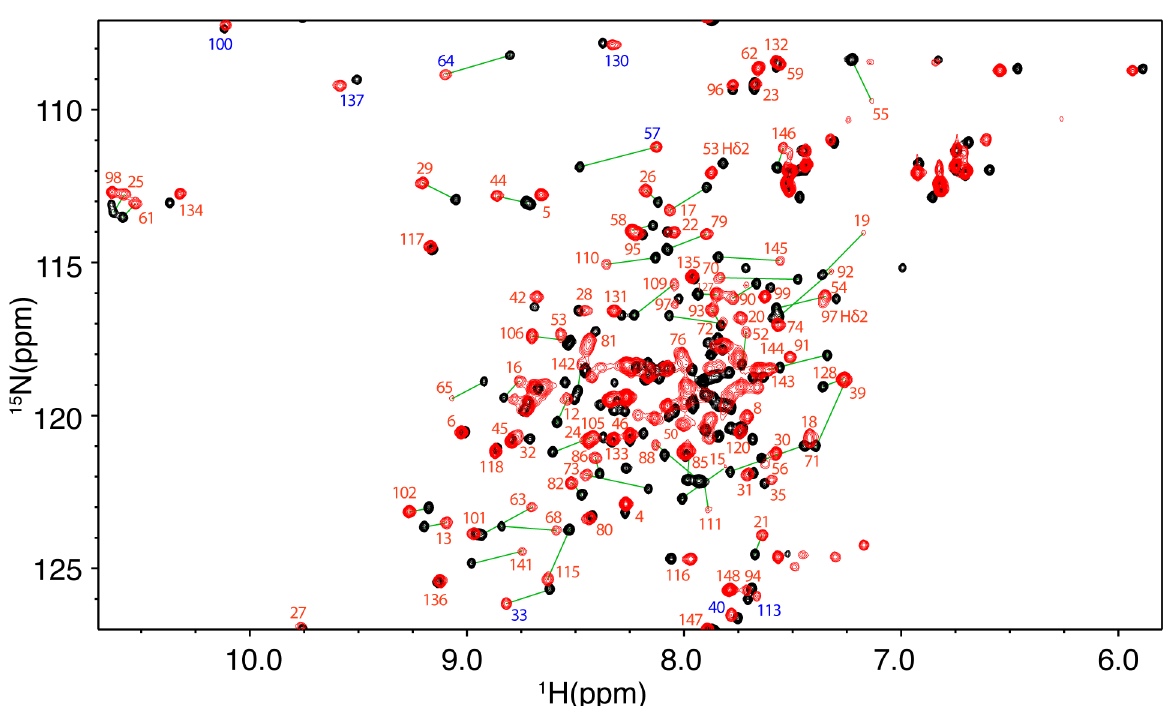
Fig 5. 2D HSQC NMR data of Ca 2+ /CaM:Fas-Pep1 complex. Overlay of 2D 1 H- 15 N HSQC spectra obtained for 15 N-labeled Ca 2+ /CaM in the free state (black) and in complex with Fas-Pep1 (red) at 1.5:1 peptide: Ca 2+ /CaM. No chemical shift changes were observed in the HSQC spectra with further addition of Fas-Pep1, indicating saturation at this ratio. Signal labels correspond to residues of CaM in the bound form. Signals labeled in blue are folded in the spectrum by 20 ppm.